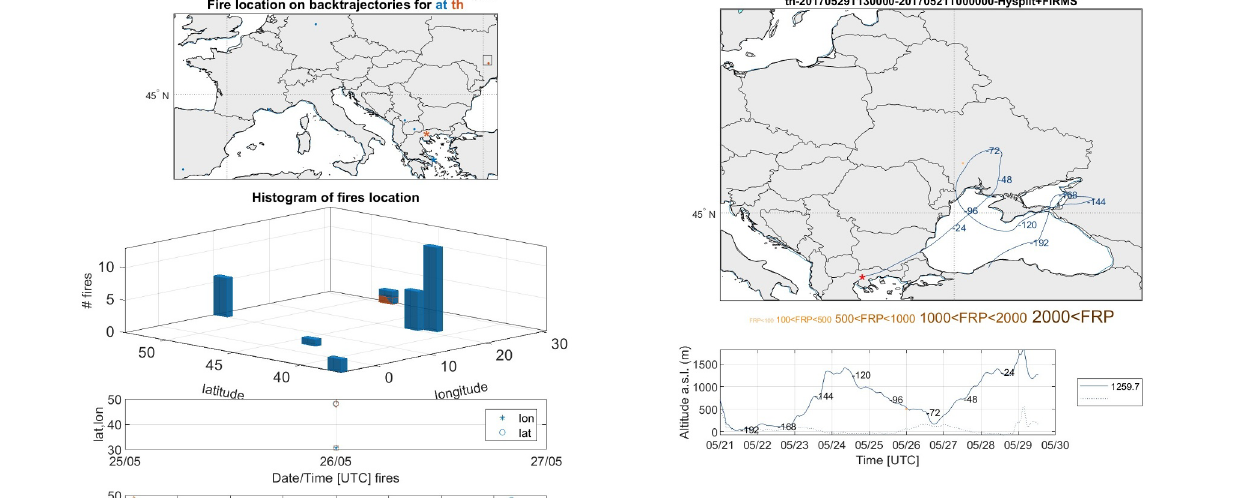
Fig. 3. Hysplit backtrajectory and fires’ location along for “th” station. Backtrajectory starting time: 13:00 20170529, altitude 1260m asl.